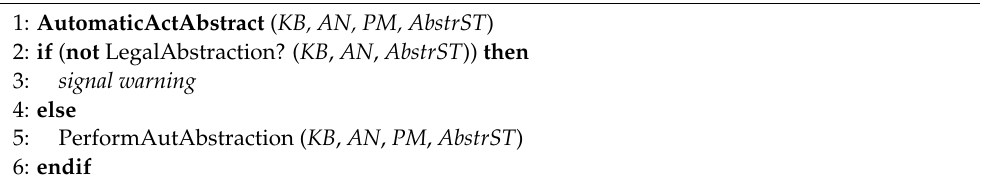
Algorithm 1: pseudocode of automatic activity-based abstraction algorithm.